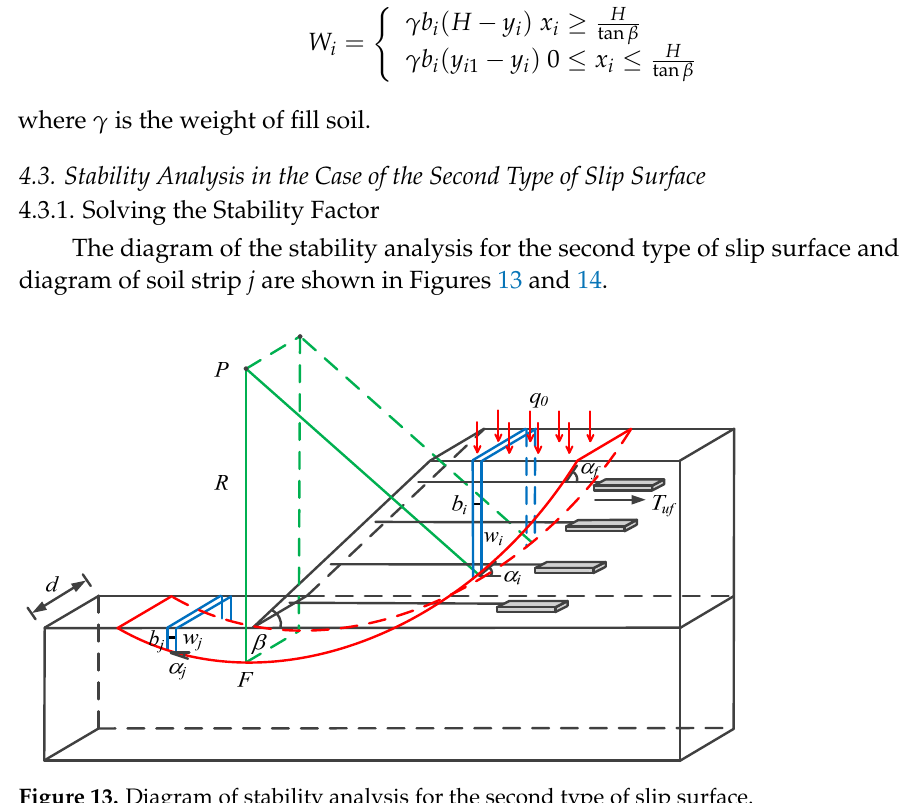
Figure 13. Diagram of stability analysis for the second type of slip surface.